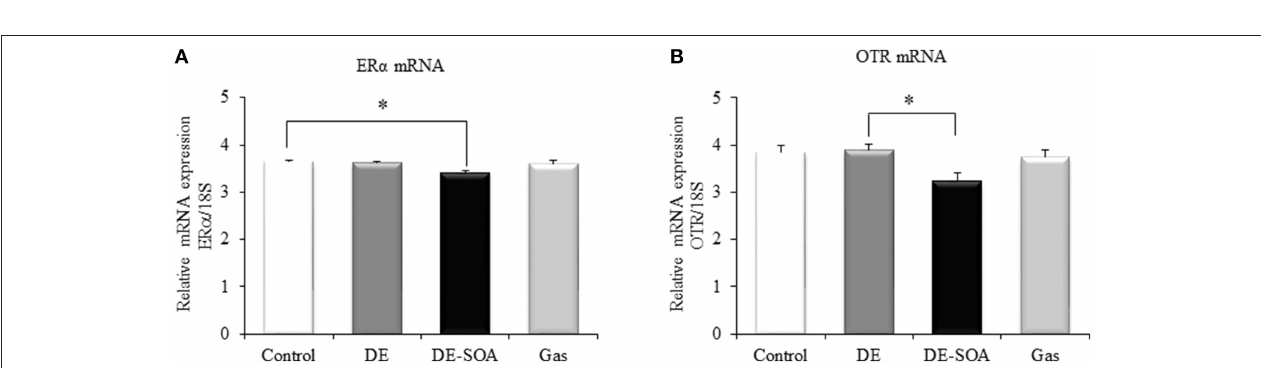
FIGURE 1 | Scores of the social behavioral tests. (A) sociability test, (B) social novelty preference test, (C) social interaction test with juvenile mouse and (D) light dark test in 13 week-old male mice after developmental period exposure to clean air, DE, DE-SOA or gas without particles. Each bar represents the mean ± SE ( n = 12 , ** P < 0.01 , * P < 0.05 ).